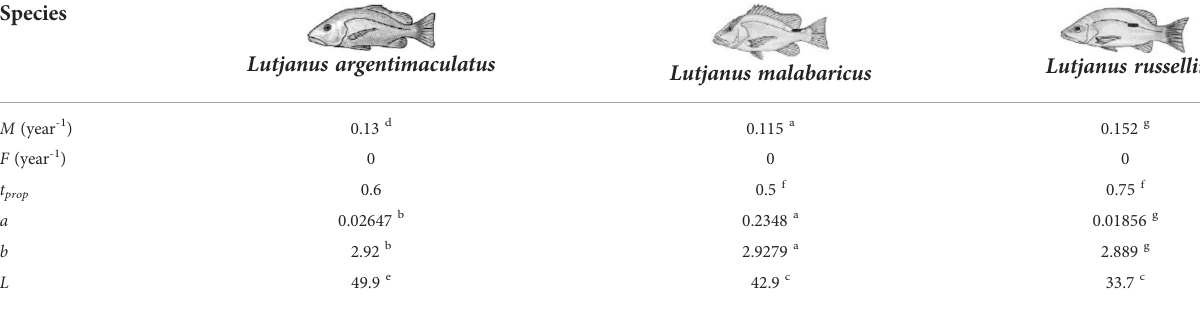
TABLE 2 Estimated mortality (natural M and fi shing F ), level of residency ( t prop ), and biomass metrics.